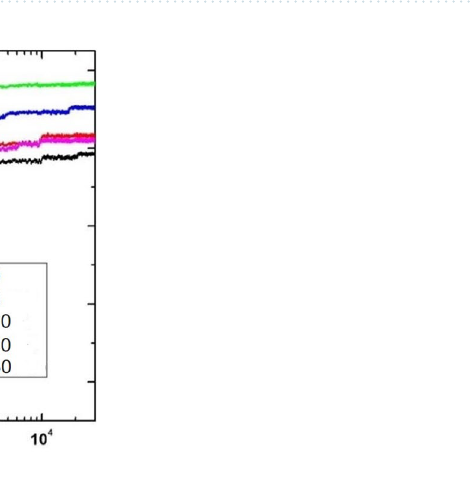
Figure 6. The characteristic diagrams at the stationary state for T = 1.05 under memory length M = 20 . From panel ( a–f ), the influence of memory weight β is fixed to be 0.1, 0.2, 0.3, 0.5, 0.7, 0.9. The red and blue colors indicate “cooperators” and “defectors”.